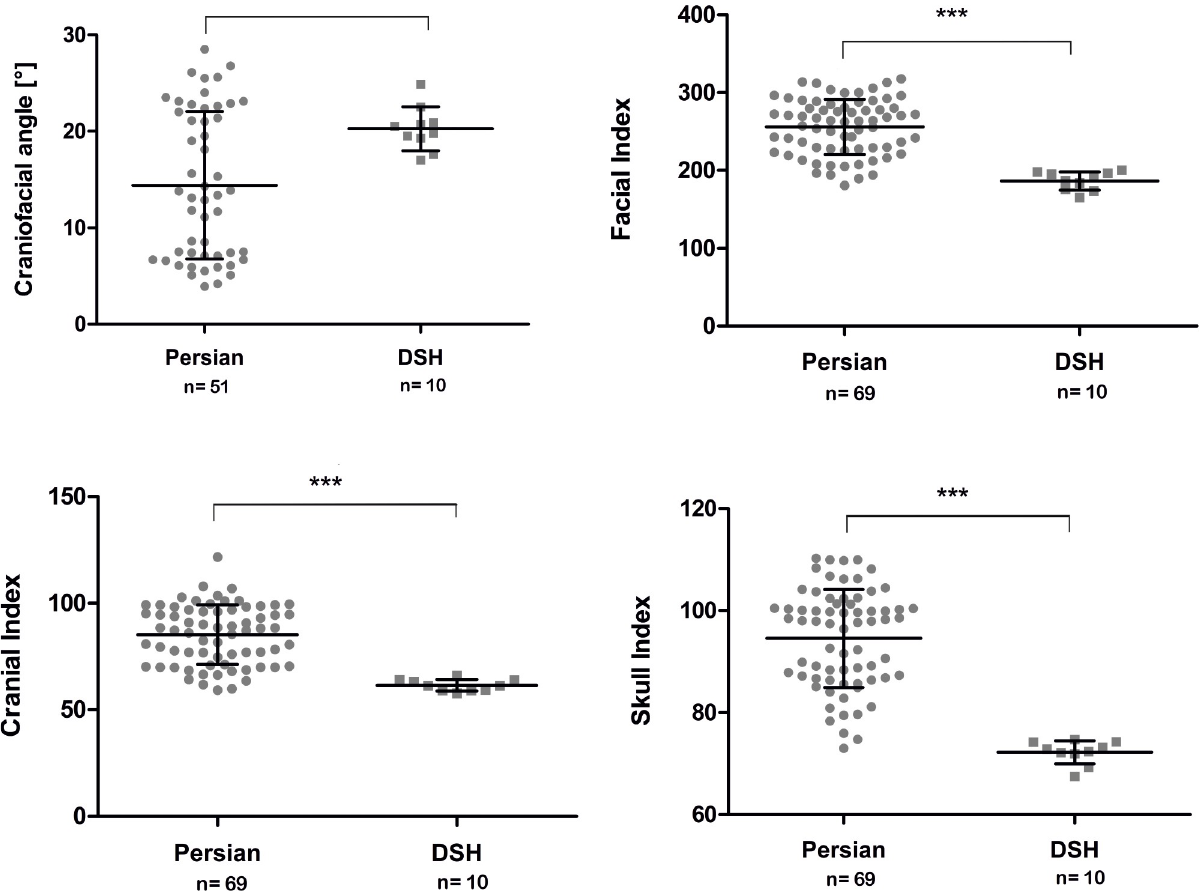
Fig 9. Comparison of craniometric properties between Persian and DSH cats. Graphic representation of the facial index, the cranial index, the skull index and the craniofacial angle, comparing Persian and DSH cats. The values of the individual cats, the mean values, the standard deviations and the significance level are